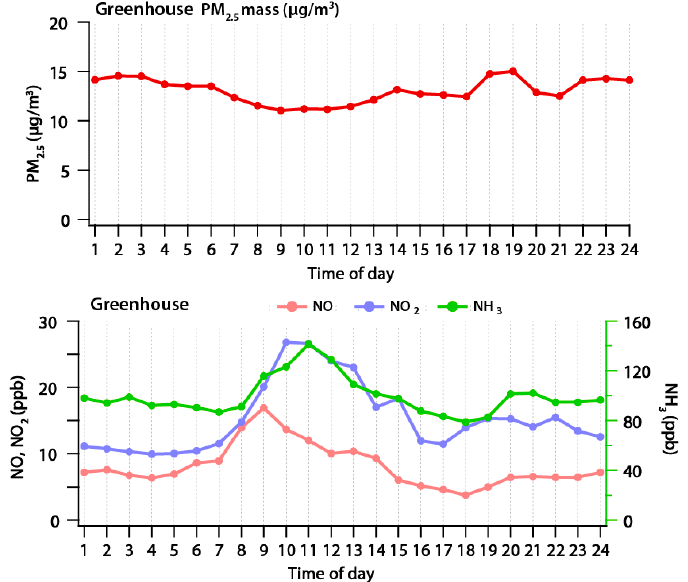
Figure 5. Time-series concentrations of PM 2.5 , NH 3 , NO and NO 2 . VOCs are air pollutants with a boiling point of 50 to 260 °C at room temperature (RT) and atmospheric pressure. Among VOCs, benzene, toluene, ethylbenzene, and xylene (BTEX) are all designated by the EPA as hazardous air pollutants (HAPs) [22,23]. In terms of PM 2.5 formation, oxygenated volatile organic compounds (OVOCs) generate particulates by themselves in the atmospheric environment through the process of condensation and nucleation, and are also involved in the photochemical reaction of ozone (O 3 ) and nitrogen oxides, which has an impact on the generation of secondary organic aerosols (SOA) and secondary nitric aerosols [24–26].